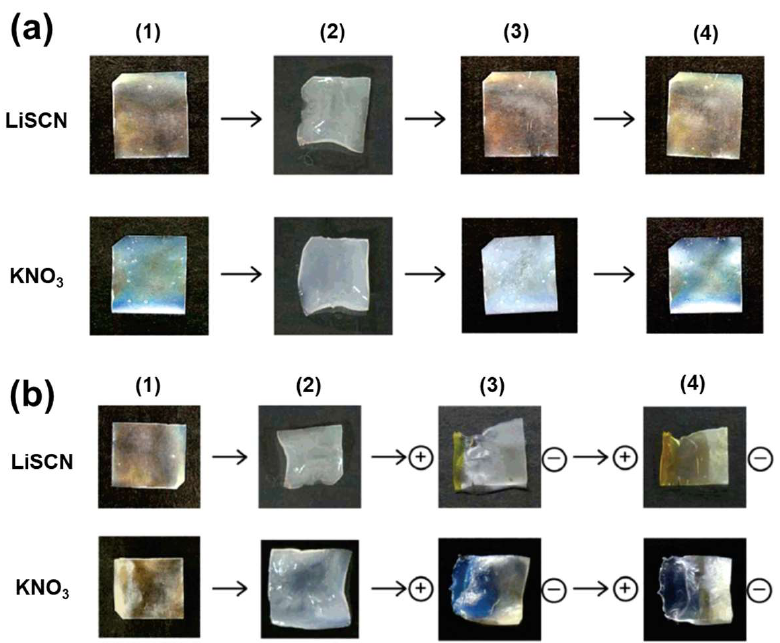
Figure 6. ( a ) Visual appearance of hydroxypropyl cellulose (HPC)/poly(di(ethylene glycol) monomethyl ether methacrylate) (PDEGMEM) gels (1) in the original state, (2) swollen in salt solutions, (3) dried after salting-in, and (4) washed with water followed by drying. The researchers used LiSCN and KNO 3 as salts. ( b ) Visual appearance of HPC/PDEGMEM gels (1) in original state, (2) swollen in salt solutions, (3) after applying the electric field, and (4) dried after turning off the electric field (( a , b ) are reprinted with permission from [70], copyright (2021) American Chemical Society). The obtained HPC-based ChLC hydrogel originally exhibited a red color, whereas the color blueshifted after air-drying for 3 d and shifted to the UV region after 3 w (Figure 7b). These color shifts are likely because shrinking the hydrogel by air-drying shrank the cholesteric helix incorporated in the hydrogel. The coloration of the gel returned to the red region after swelling with water, and Müller and Zentel [51] cycled the color change between the red to UV